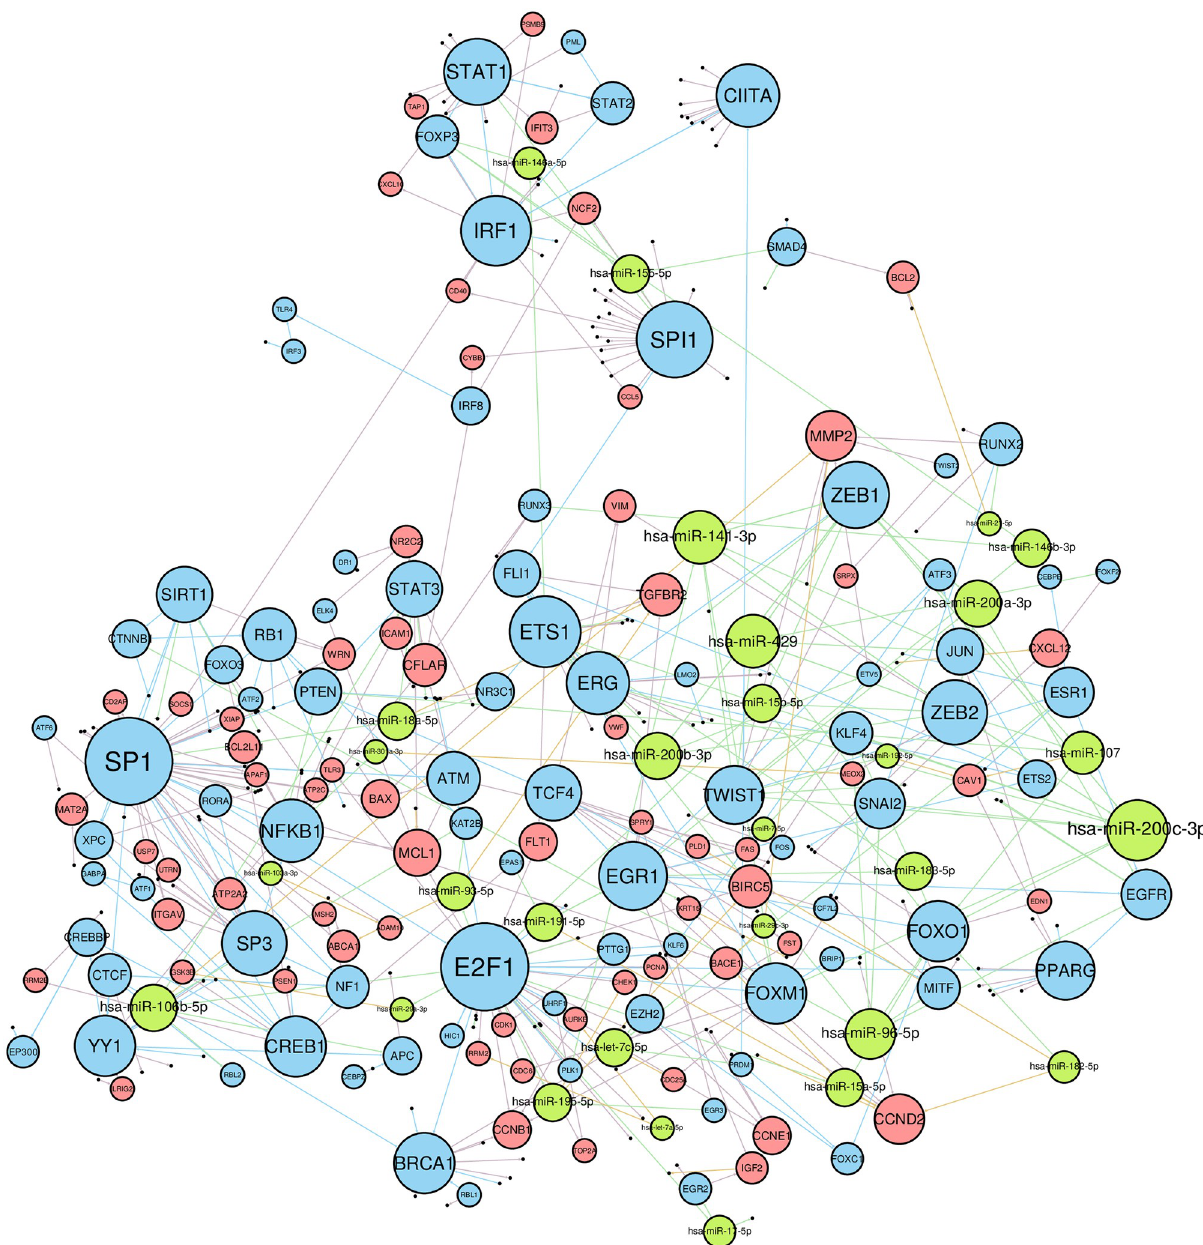
Fig 2. The main component of the breast cancer interaction network. Blue nodes represent TFs, red nodes represent genes, green nodes represent miRNAs. The higher node degree is, the bigger is the node size. Edges are colored according to node types they connect.